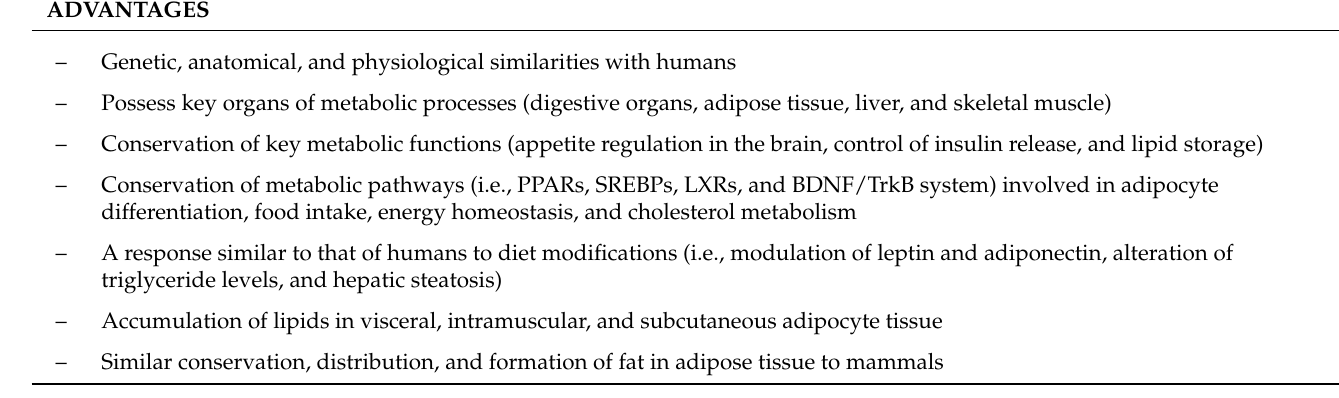
Table 1. Advantages and disadvantages of using zebrafish as a model of obesity and metabolic